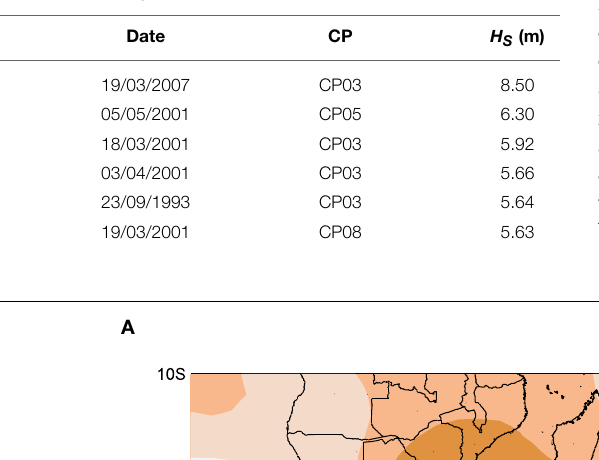
Frontiers in Environmental Science |